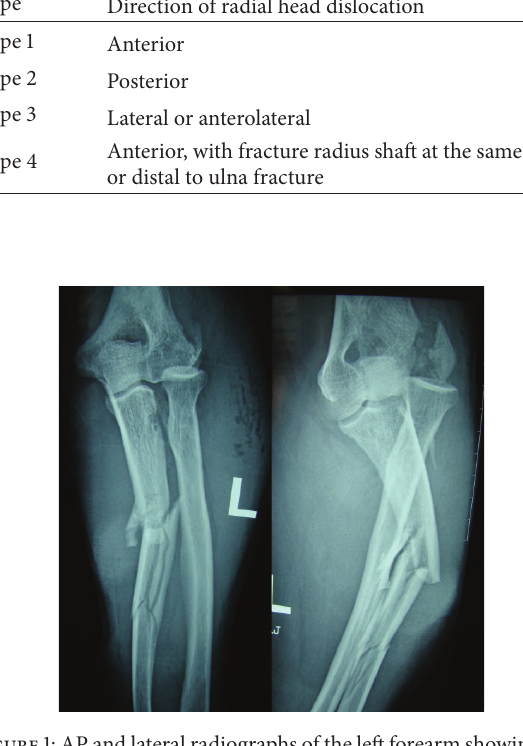
Figure 1: AP and lateral radiographs of the left forearm showing the Monteggia type 2 variant with fractured lateral humeral epicondyle.